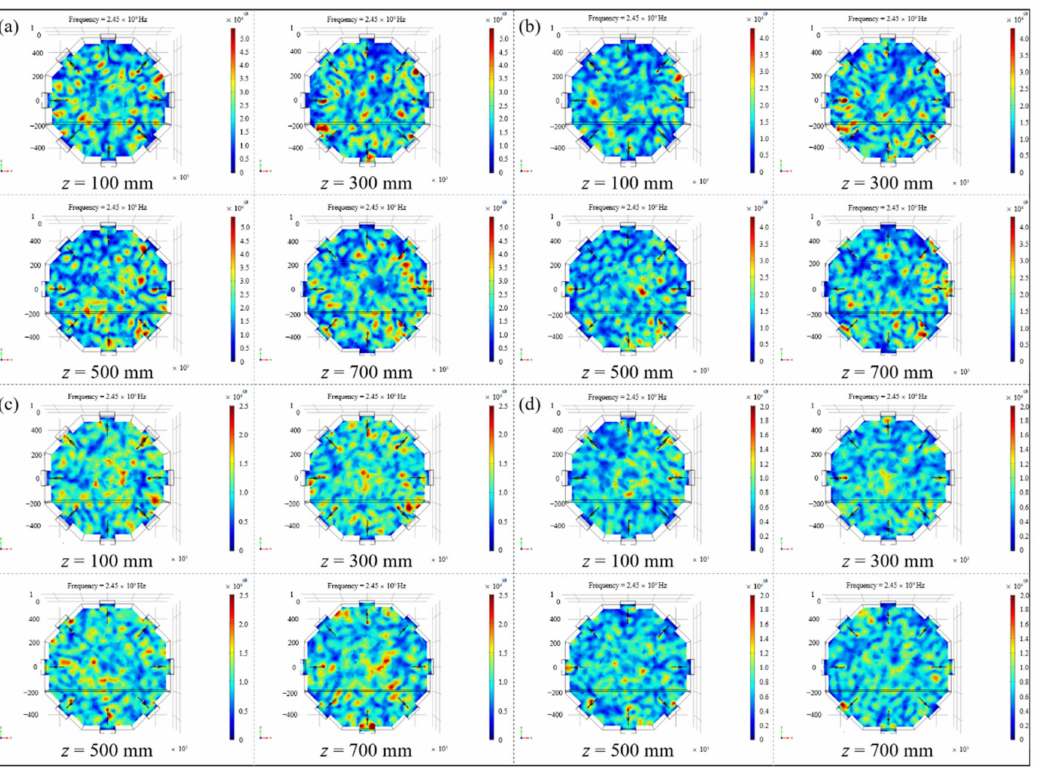
Figure 9. Sliced nephograms of spatial electric field under different arrangements of microwave generators: ( a ) number (6); ( b ) number (9); ( c ) number (16); ( d ) number